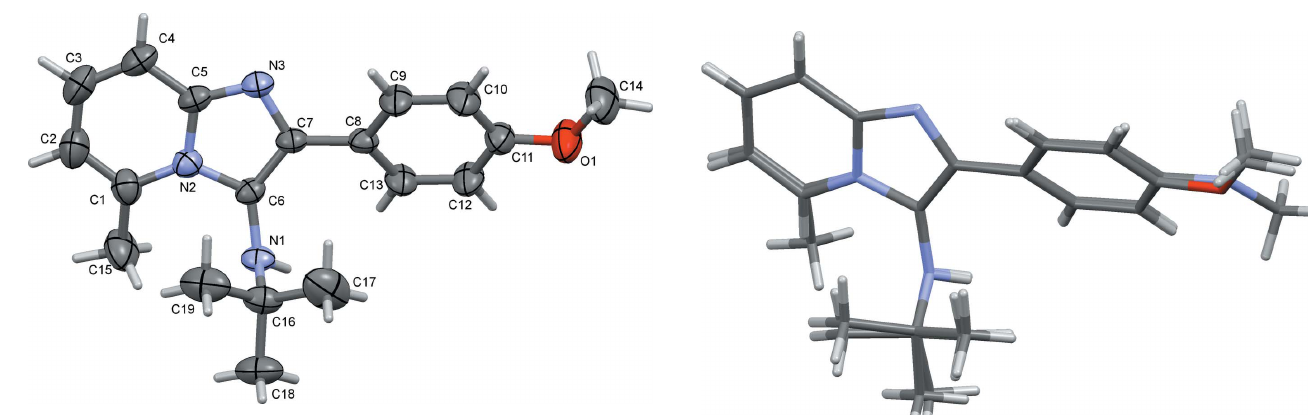
Figure 3 A structural overlap view of molecules (I) and (II).